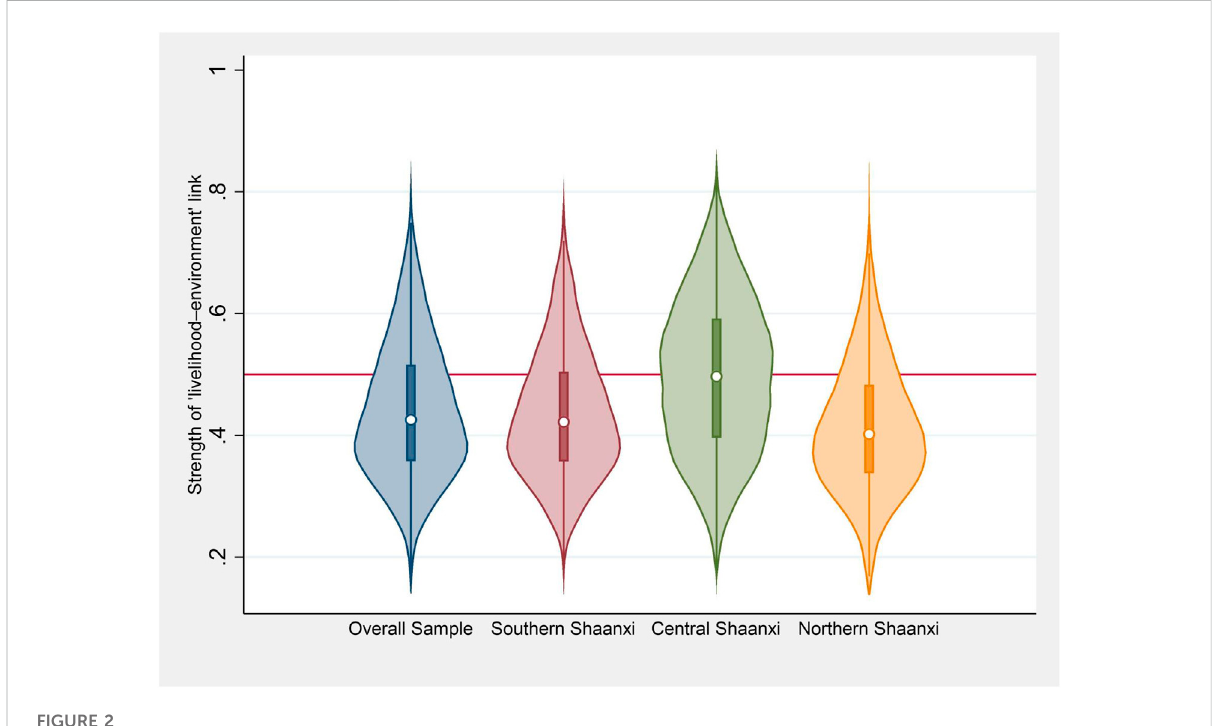
FIGURE 2 The overall and regional distribution of “ livelihoods – environment ” links. ① Red line represents a link degree of 0.5. ② The differences among three regions are signi fi cant at p < 0.01 according to t